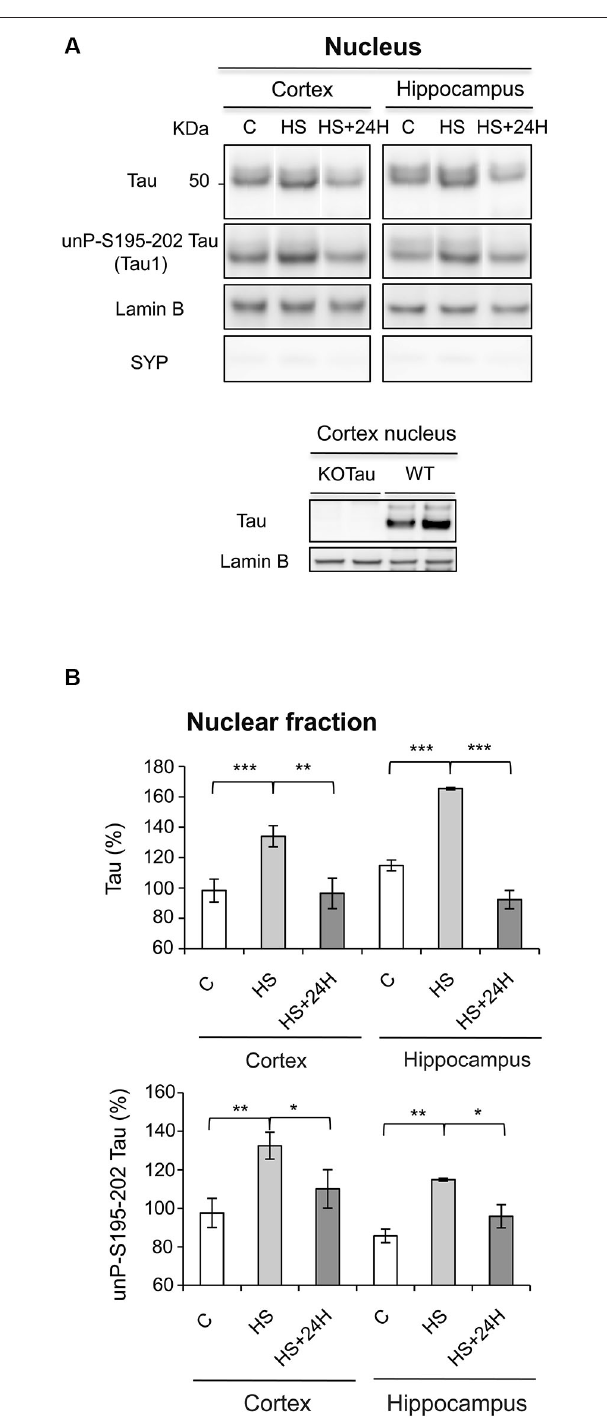
FIGURE 3 | Nuclear Tau protects genomic DNA integrity from hyperthermia-induced damage. (A) Nuclear extracts from the cortex and hippocampus of WT mice in the control (C) condition, after HS or after a 24-h recovery after HS (HS+24 h) were analyzed using immunoblotting for Tau independent of phosphorylation (Tau) and Tau unphosphorylated at epitope S195-202 (Tau1). Lamin B and synaptophysin (SYP) were used as specific nuclear and cytoplasmic markers,